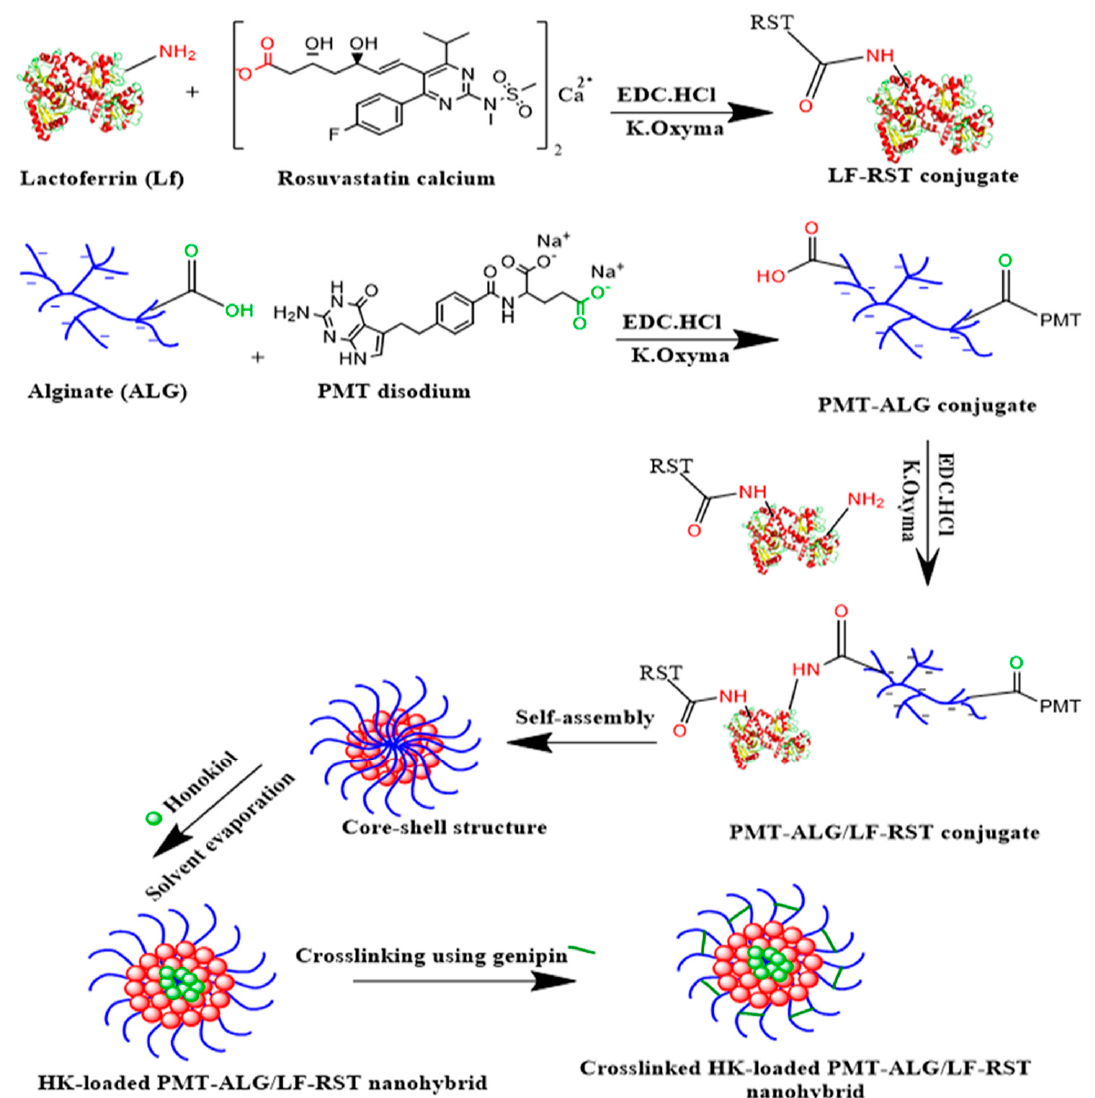
Figure 1. Schematic diagram showing the formulation stages of crosslinked HK-loaded PMT– ALG/LF–RST NH F10 .